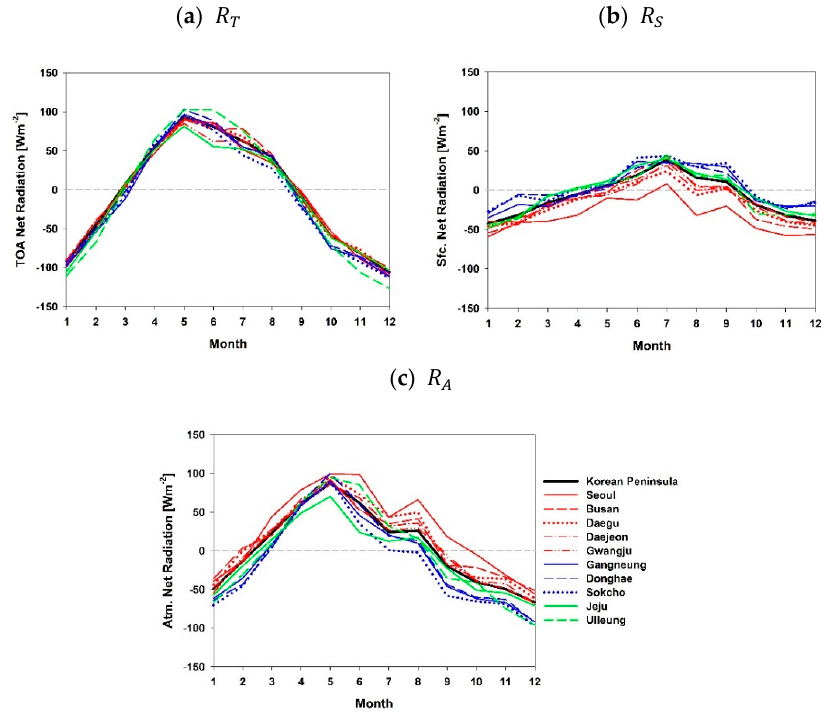
Figure 16. Monthly mean energy budget time series for the Korean Peninsula and cities by region in 2016 at ( a ) the top of the atmosphere; ( b ) the surface; and ( c ) in the atmosphere.